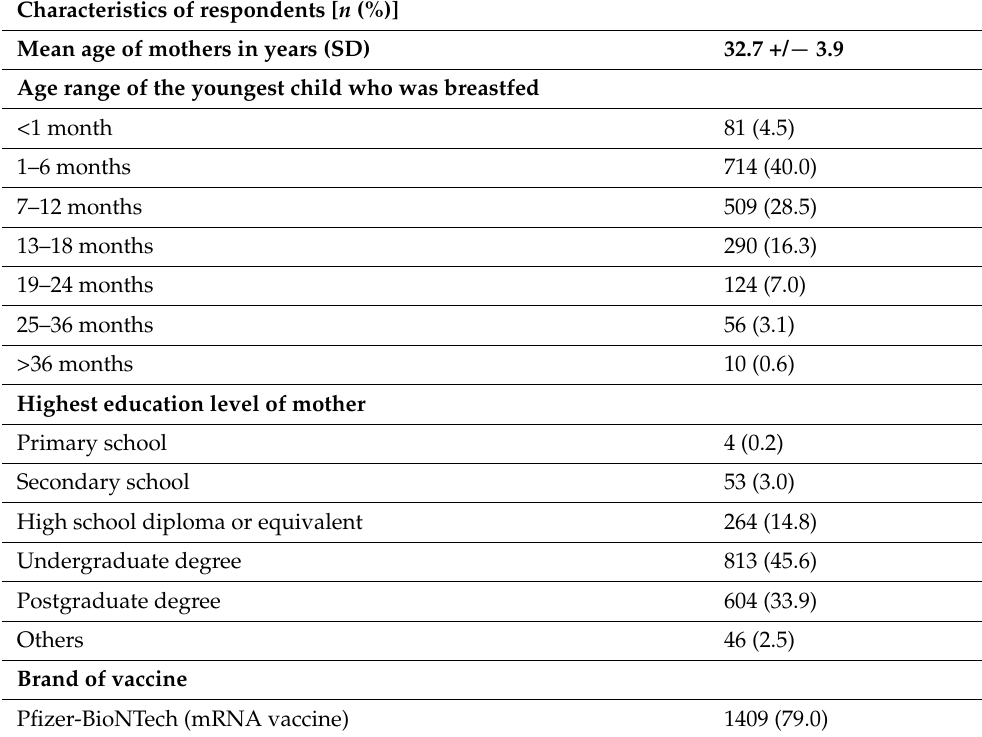
Table 1. Demographic characteristics of breastfeeding mother–child dyads ( n =